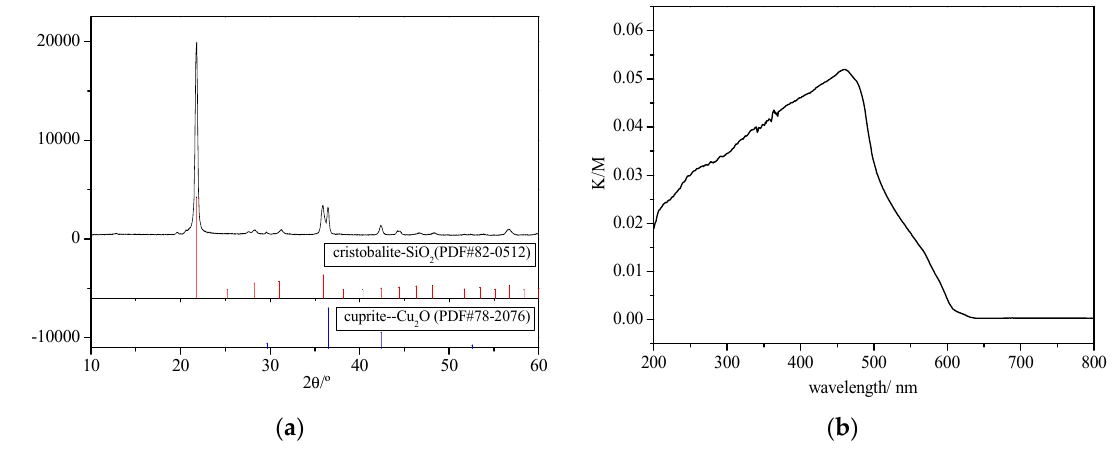
Figure 7. The analysis of the Cu-Al/SiO 2 porous material with CTAB after denitrification reaction. ( a ) The X-ray diffractometer (XRD) analysis; ( b ) The Ultraviolet–visible spectroscopy (UV–Vis) analysis.